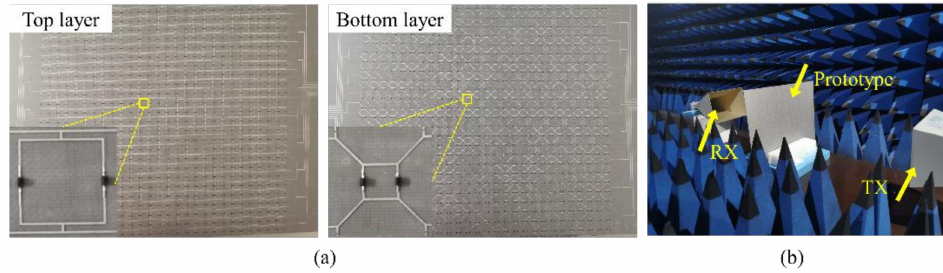
Figure 7. ( a ) The surface appearance of the prototype. ( b ) The specific test environment. The measured results are shown in Figures 8 and 9. It is clearly revealed from Figure 8 that the varactor diodes on the top and bottom layer can regulate the shifts of the dual- transmission windows independently. When C v 1 changes from 0.35 pF to 3.20 pF and C v 2 is kept at 0.466 pF, the resonance frequency f 1 moves from 2.74 GHz to 2.21 GHz, and the resonance frequency f 2 approximately remains at 4.85 GHz. Conversely, when C v2 varies and C v 1 is constant, the resonance frequency f 2 changes from 4.85 GHz to 4.30 GHz and the resonance frequency f 1 approximately remains at 2.74 GHz.